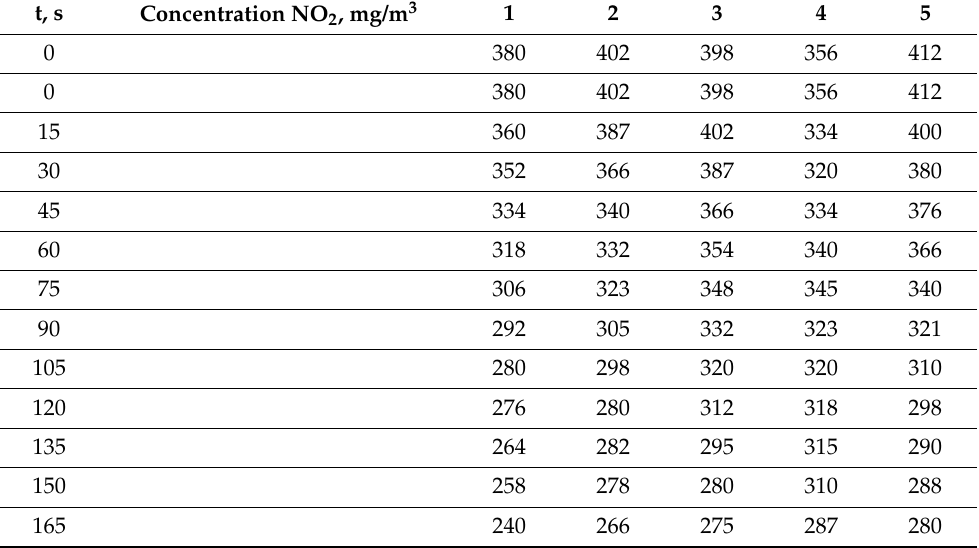
Table 2. The concentration of nitrogen oxides in the explosion products of pentaerythritol tetranitrate with 20% zinc carbonate ZnCO 3 in the stemming (compiled by the author R.S.